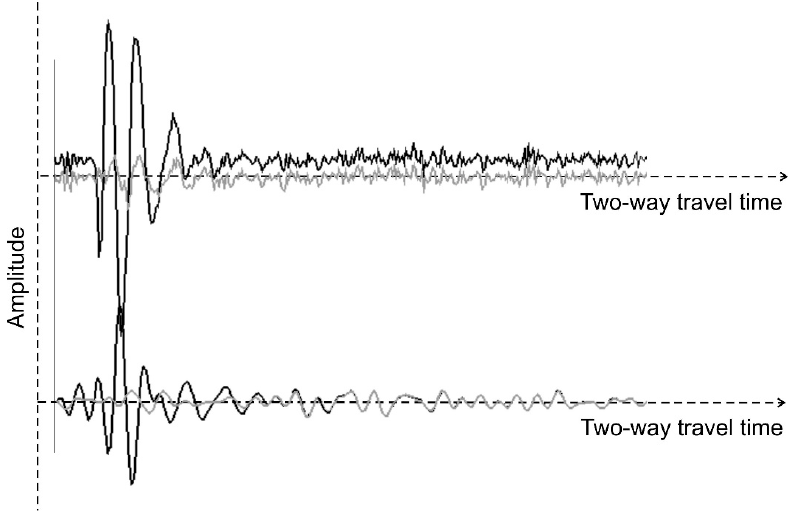
Figure 3. The black A-scan is the original trace. The grey A-scan is the trace obtained after the subtracting average processing. Above, before the application of a band-pass filter. Below, after applying a band pass filter with cut-off frequencies 10 MHz and 55 MHz.